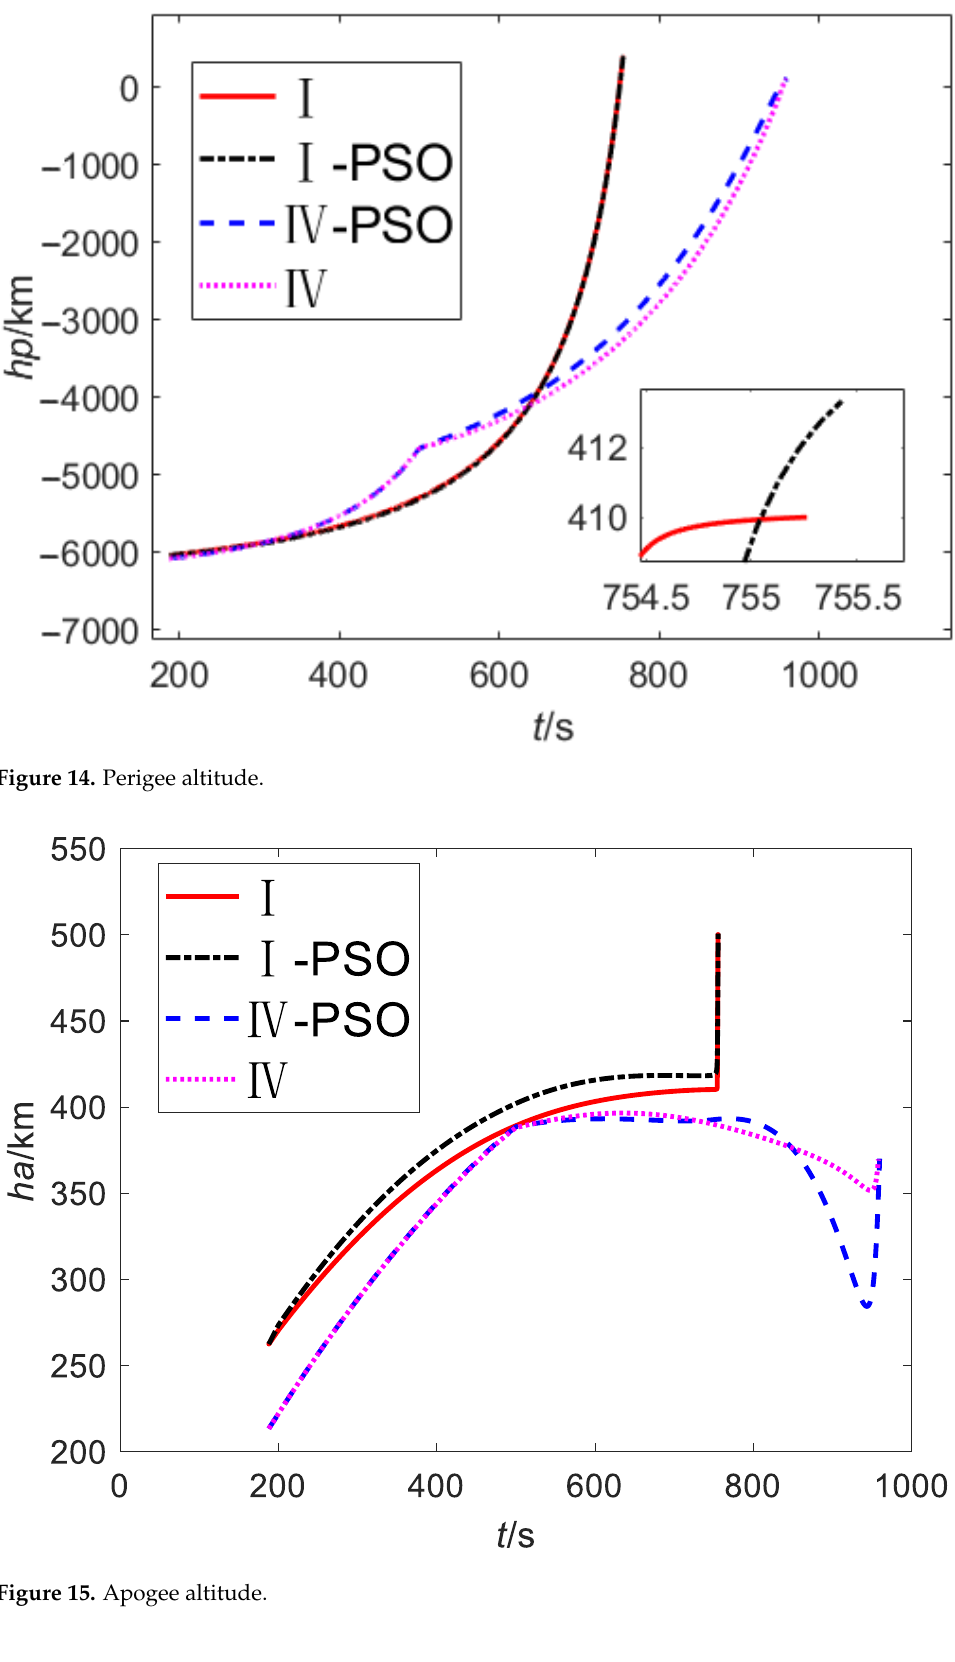
Figure 15. Apogee altitude. Figure 15. Apogee